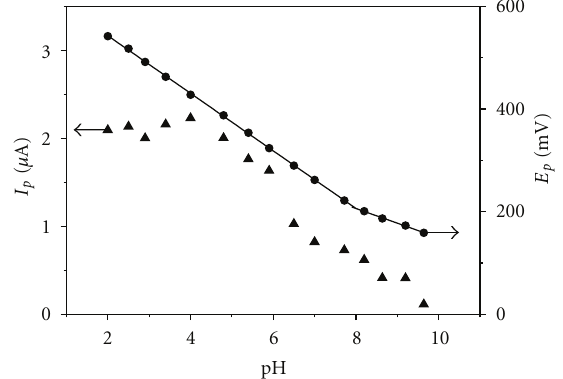
Figure 3: Dependence of anodic CV peak potential and peak current of rutin ( c = 0.1mmol L − 1 ) on pH. The conditions of the experiments are given in the legend to Figure